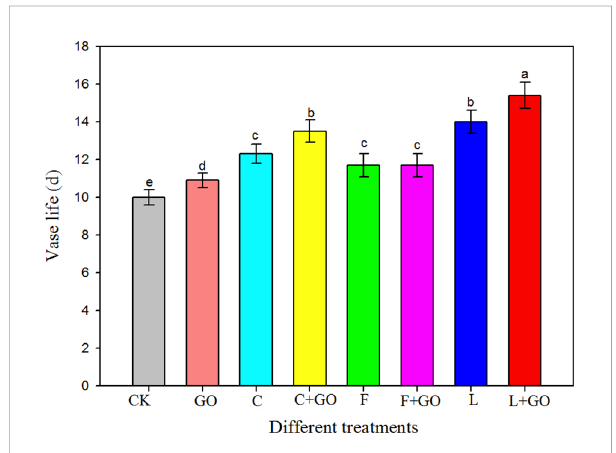
FIGURE 2 Vase life of the fresh cut roses in different treatment groups. Different lowercase letters indicate signi fi cant difference among different groups at p< 0.05.